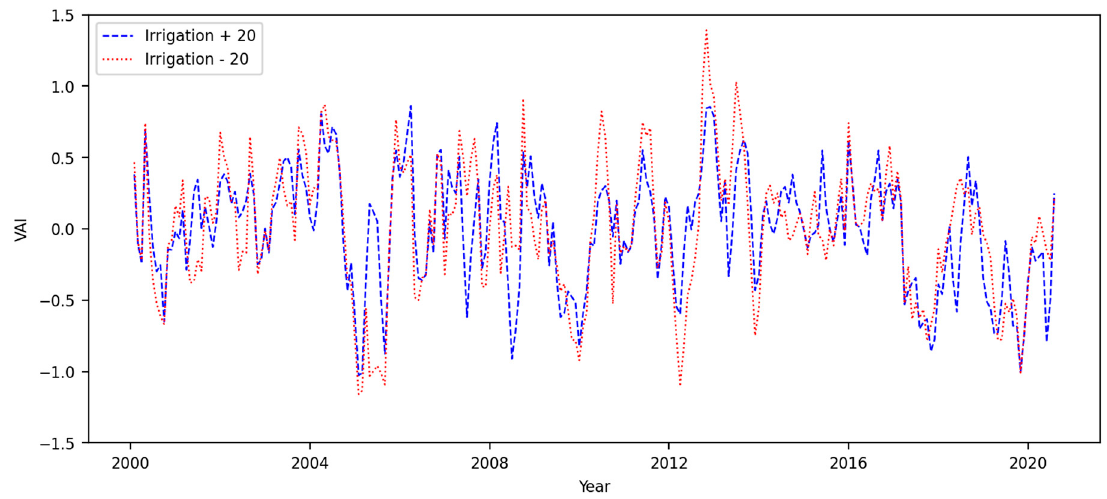
Figure 9. VAI time series at the Andalusia site in pixels with more than 20% of irrigated area and in pixels mainly rainfed or less than 20% of irrigated area.